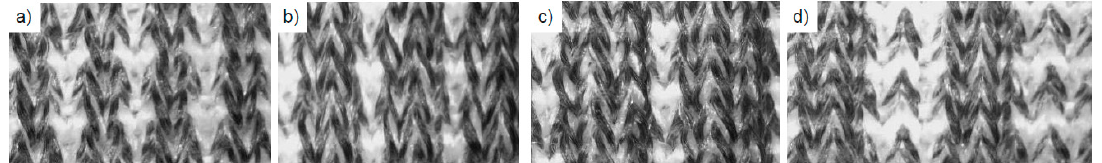
Figure 15. Images of knitted rib structures. ( a ) 1 × 1, ( b ) 1 × 3, ( c ) 1 × 2 and ( d ) 2 × 2 structure [66].